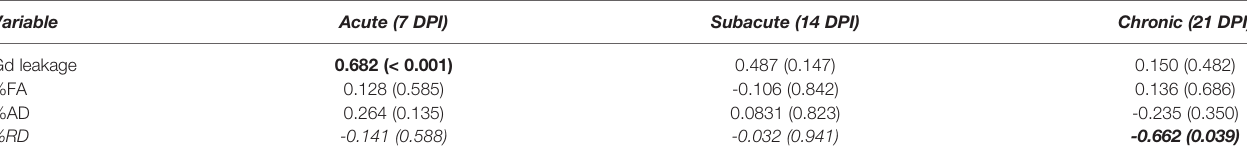
Dataindicatesstandardizedpartialregressioncoef fi cient(p-value).DPI,daypostcytokineinjection;%FA,FApositivearearatiotospinalcord;%AD,ADpositivearearatiotospinalcord;% RD, RD negative area to spinal cord. Bold values: p < 0.05.